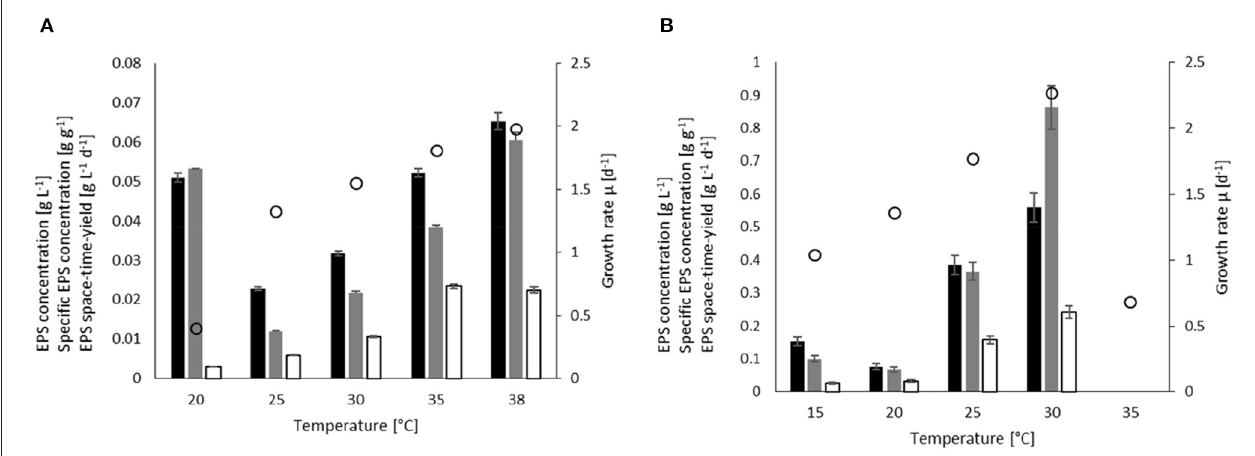
FIGURE 2 | Effect of temperature on the EPS concentration (black), EPS yield (gray), space-time yield (white) and specific growth (white circles) in batch processes for (A) A. platensis cultivated at 277 µ mol m − 2 s − 1 , and (B) C. asymmetrica cultivated at 476 µ mol m − 2 s − 1 .